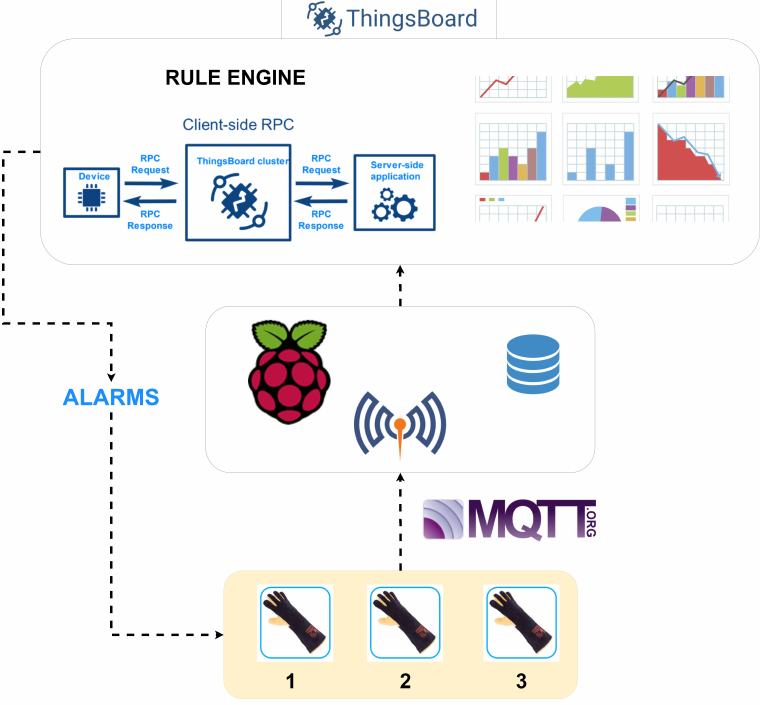
Figure 7. System architecture.